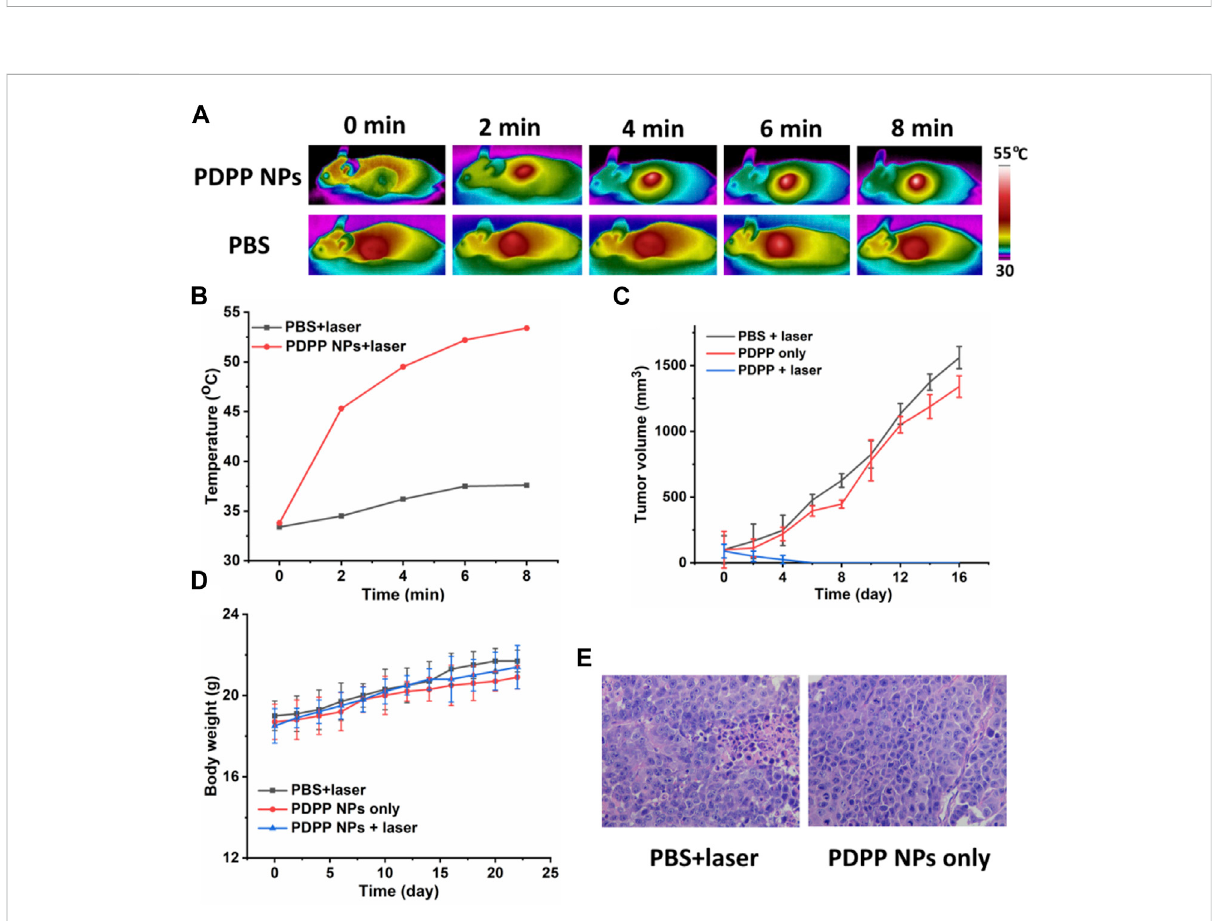
FIGURE 4 (A) Time-dependent photothermal imaging of tumor with irradiation (730 nm, 500 W/cm 2 , 8 min). (B) Quanti fi cation of tumor temperature at different time intervals. (C) Tumor volume of the mice in PBS + laser, PDPP NP-only, and PDPP NPs + laser groups (730 nm, 500 W/cm 2 , 8 min). (D) Body weight change. (E) H&E-stained pictures of the tumors in the PBS + laser and PDPP NP-only